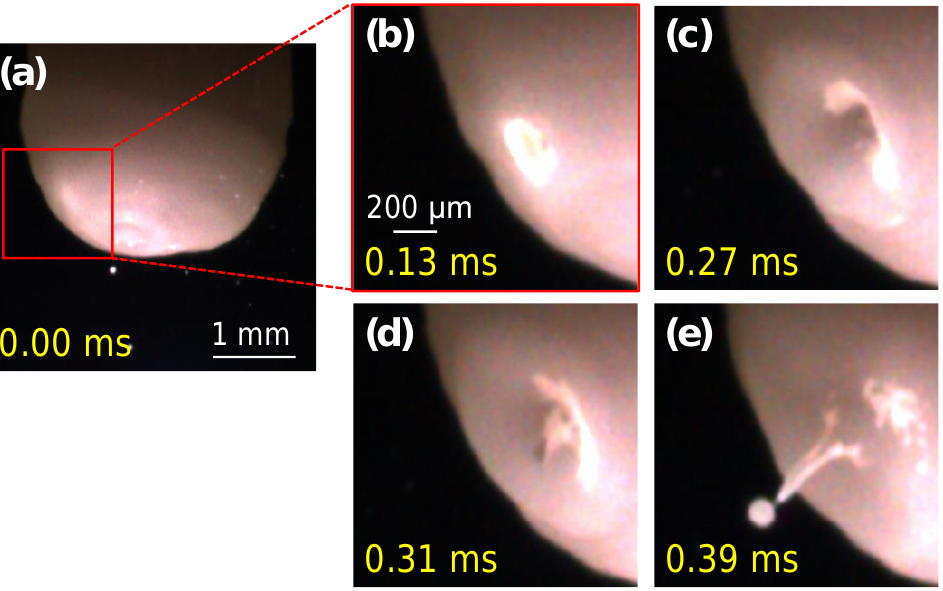
Figure 6. Representative images of the electrode’s appearance during AC TIG welding: ( a ) t = 0.00 ms; ( b ) t = 0.13 ms; ( c ) t = 0.27 ms; ( d ) t = 0.31 ms; and ( e ) t = 0.39 ms.